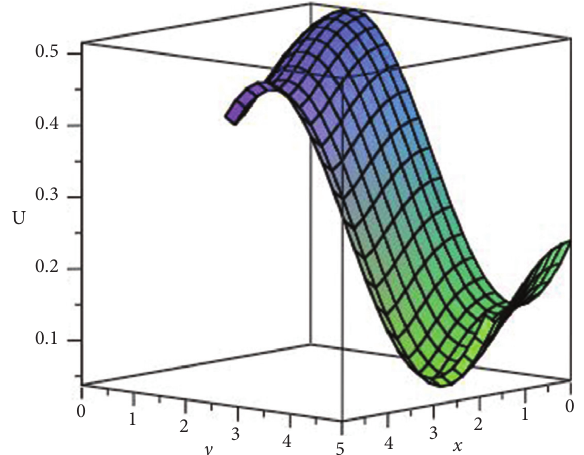
Figure 4: Graph of w given by (44) for C � 0.5, D � 1, and C